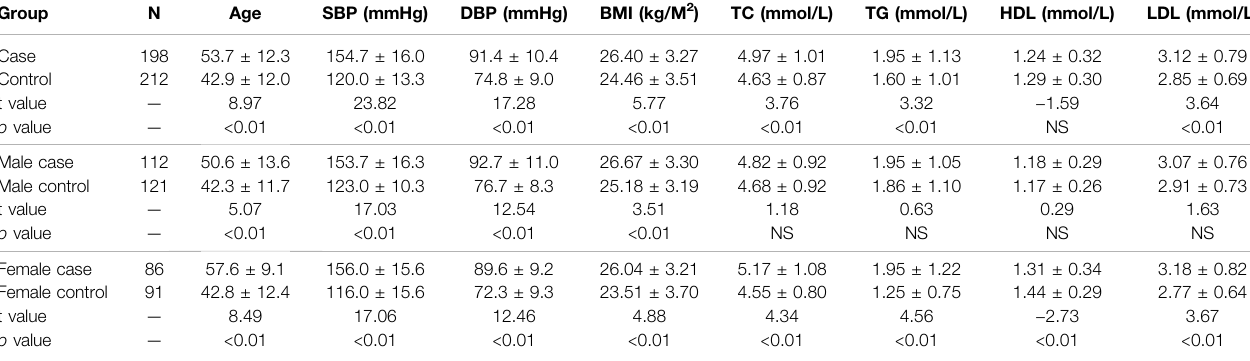
TABLE 1 | Basic clinical characteristics of EH cases and controls in the Han population.